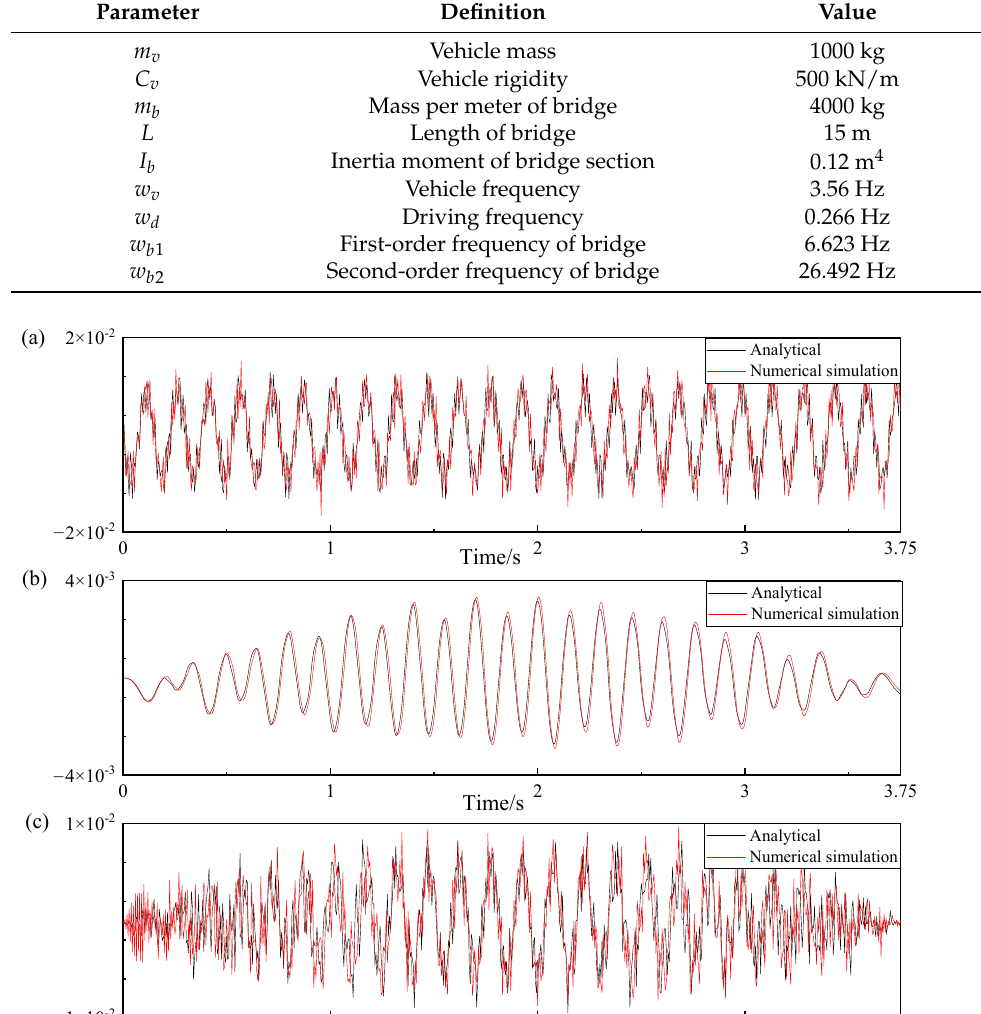
Figure 3. Single ‐ DOF sprung mass moving along a simply supported bridge beam model. Table 1. Essential parameters of the vehicle–bridge system. Table 1. Essential parameters of the vehicle–bridge system.